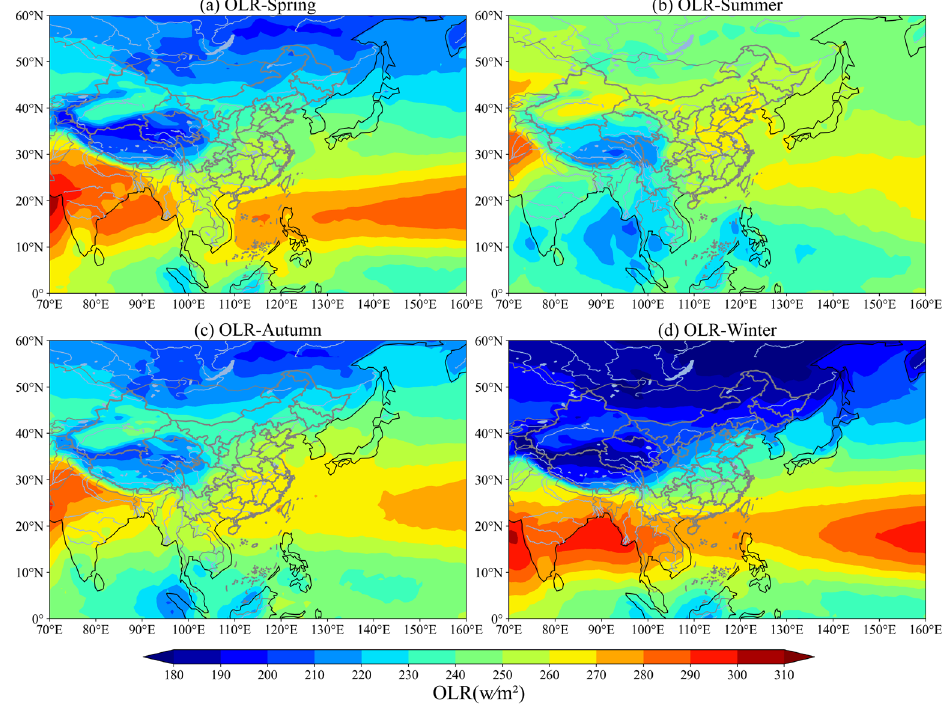
F igure 2. Seasonal spatial variation distribution of OLR in East Asia in the past 19 years .